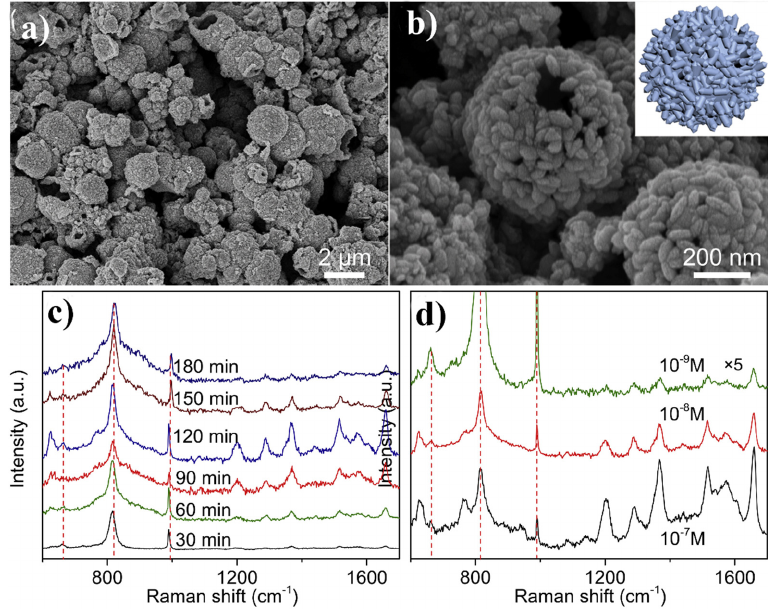
Figure 14. ( a , b ) SEM images of hollow MoO 2 spheres, inset shows the schematic structure of this nanomaterial, ( c ) SERS spectra of rhodamine 6G adsorbed on the hollow MoO 2 nanospheres after various anodization times from 10 –7 M rhodamine 6G solution, ( d ) SERS spectra of rhodamine 6G adsorbed from solutions with different concentrations on the hollow MoO 2 nanospheres. Reprinted with permission from